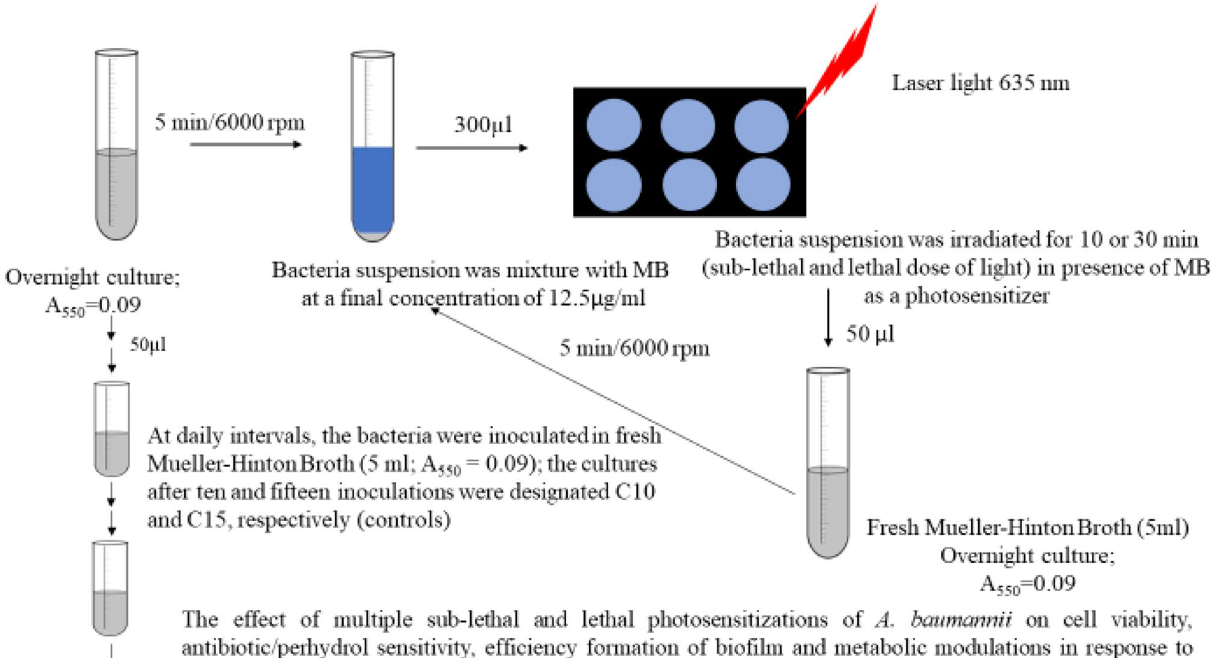
Figure 2. A protocol for conducting multiple sub-lethal and lethal photosensitizations of A.